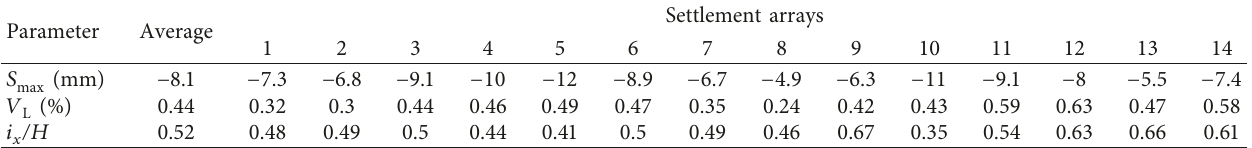
Figure 5: Transversal settlement troughs measured in down-track tunnelling. Table 3: Estimated volume loss parameters from down-track